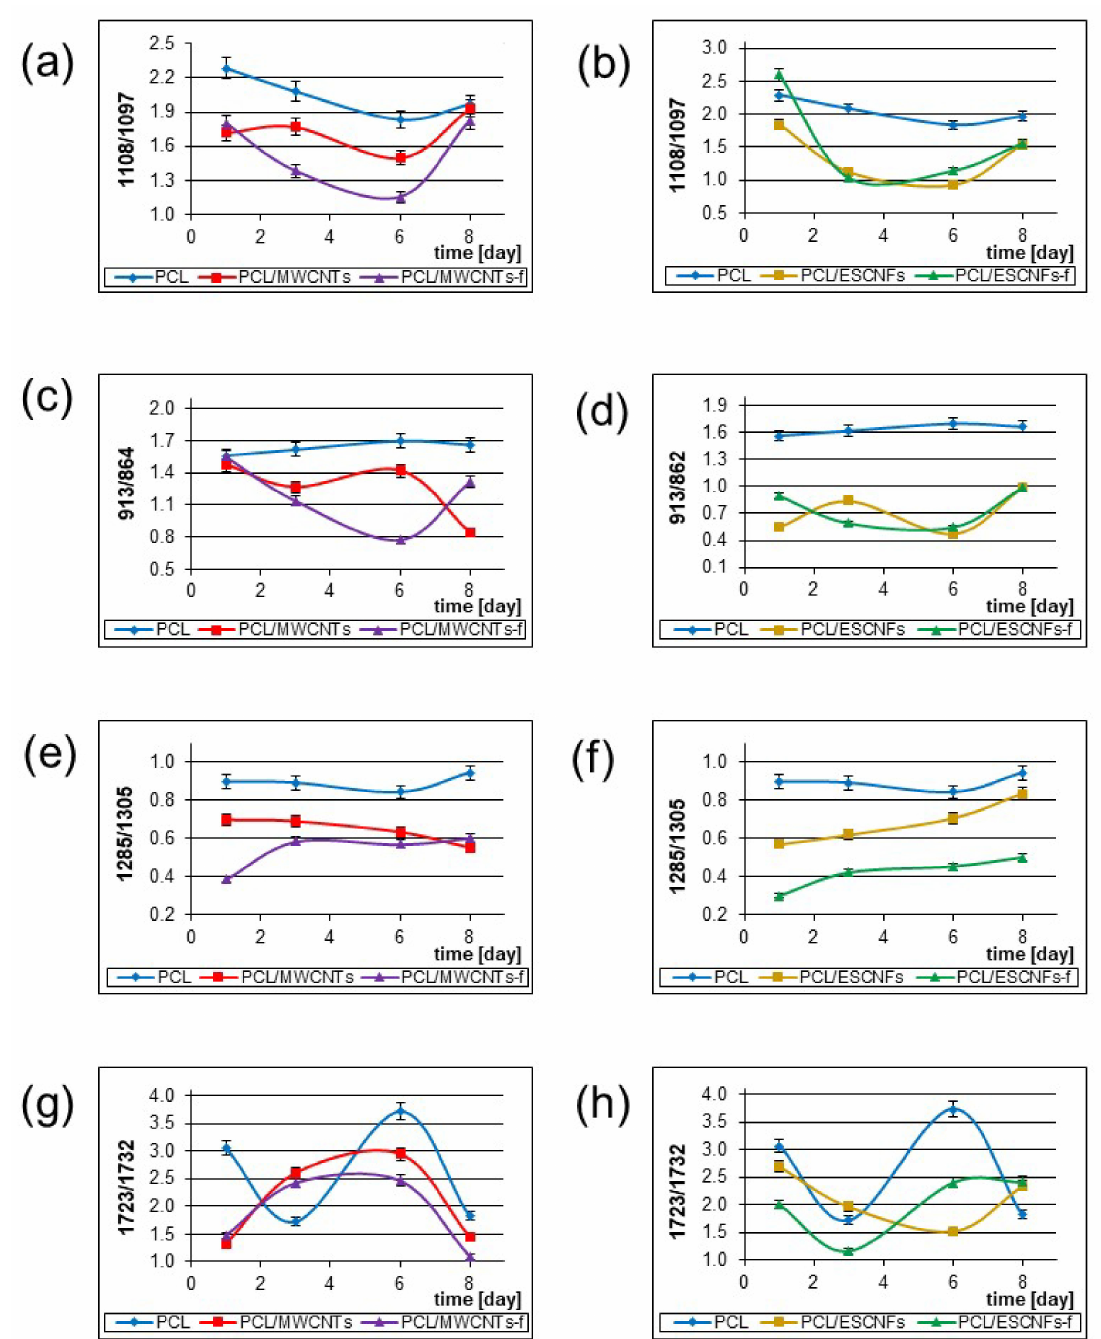
Figure 6. The intensity ratio (integral) of the PCL marker bands characterizing the crystallinity of the tested polymer nanomaterials constituting the substrate for U-2 OS cell culture, in the following days of culture. For PCL, PCL/MWCNTs, PCL/MWCNTs-f: ( a ) 1108/1097 cm − 1 (Statistical analysis with PCA with Calibration 99.8774%; Validation 99.50629%); ( c ) 913/864 (Statistical analysis with PCA with Calibration 99.12821%; Validation 93.47666%); ( e ) 1285/1305 (Statistical analysis with PCA with Calibration 99.94765%; Validation 99.68526%); ( g ) 1723/1732 (Statistical analysis with PCA with Calibration 99.97593%; Validation 99.81823%) and for PCL, PCL/ESCNFs, and PCL/ESCNFs-f: ( b ) 1108/1097 (Statistical analysis with PCA with Calibration 99.8774%; Validation 99.6284%); ( d ) 913 /864 (Statistical analysis with PCA with Calibration 99.7179%; Validation 97.28348%); ( f ) 1285/1305 (Statistical analysis with PCA with Calibration 99.94656%; Validation 99.65956%); ( h ) 1723/1732 (Statistical analysis with PCA with Calibration 99.98973%; Validation 99.85501%), variance is defined by y-axis error bars, OMNIC